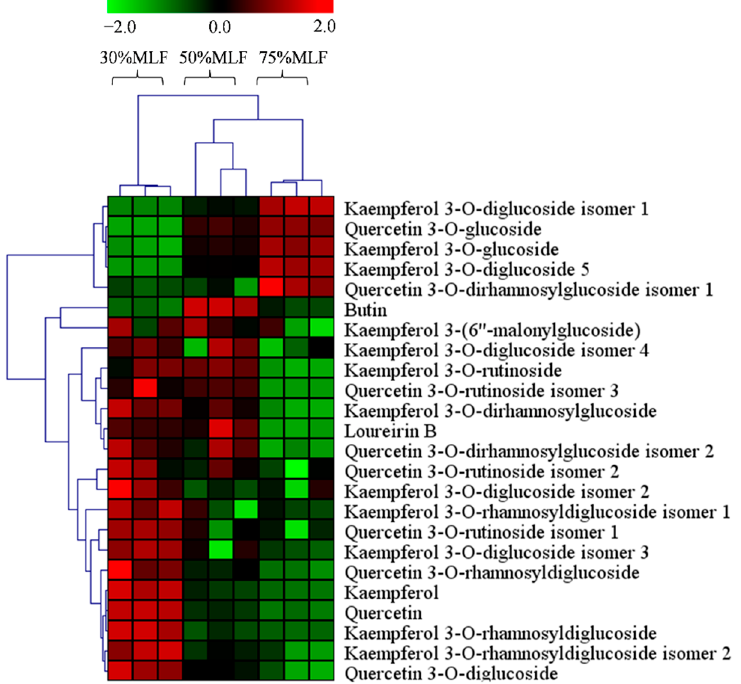
Figure 6. Heatmap of the flavonoid contents of 30%MLF, 50%MLF, and 75%MLF. Green indicates that the flavonoid level was less than the mean level in the MLFs, whereas red indicates that the flavonoid level was higher than the mean level.